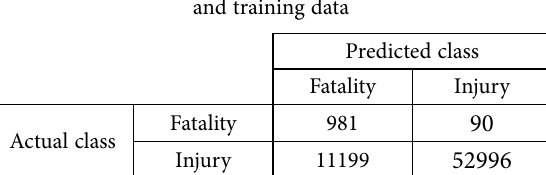
Table 2. Classification matrix for the fatality and injury victims of road accidents in the case of an un-pruned tree